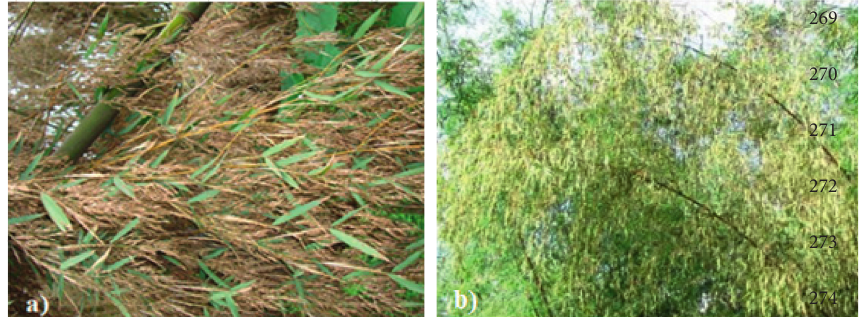
Figure 5: Bamboo mass flowering and seed production of (a) O. alpina in Hula district of Sidama Zone, SNNPR in 2017 and (b) O. abyssinica (source: